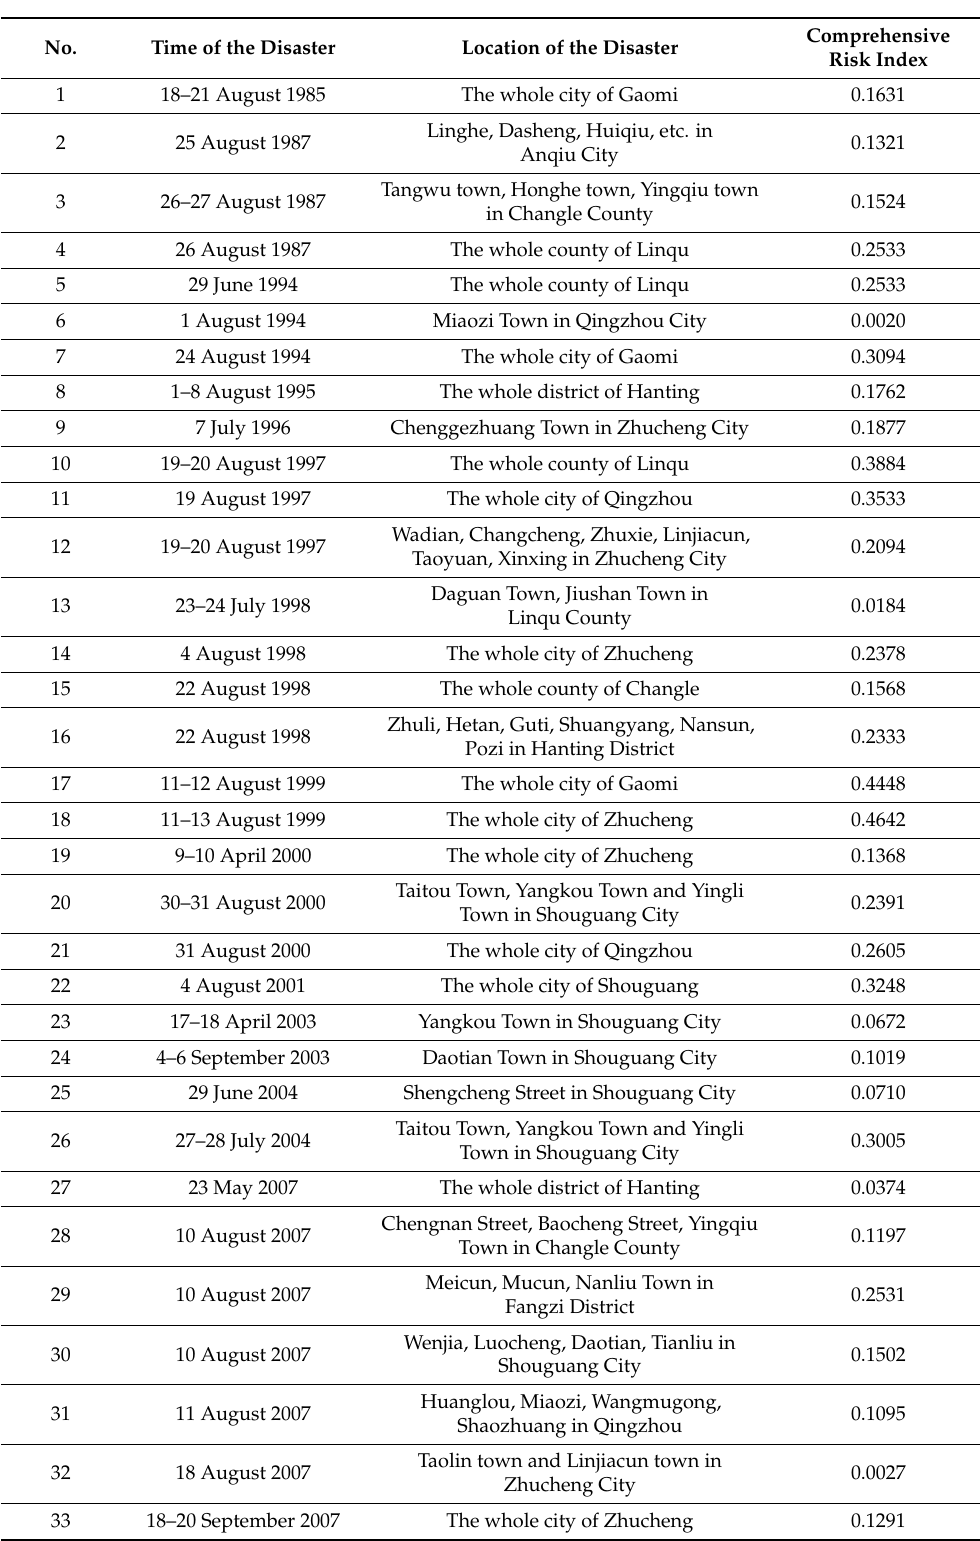
Table 2. CRIs of flash-flood disasters in